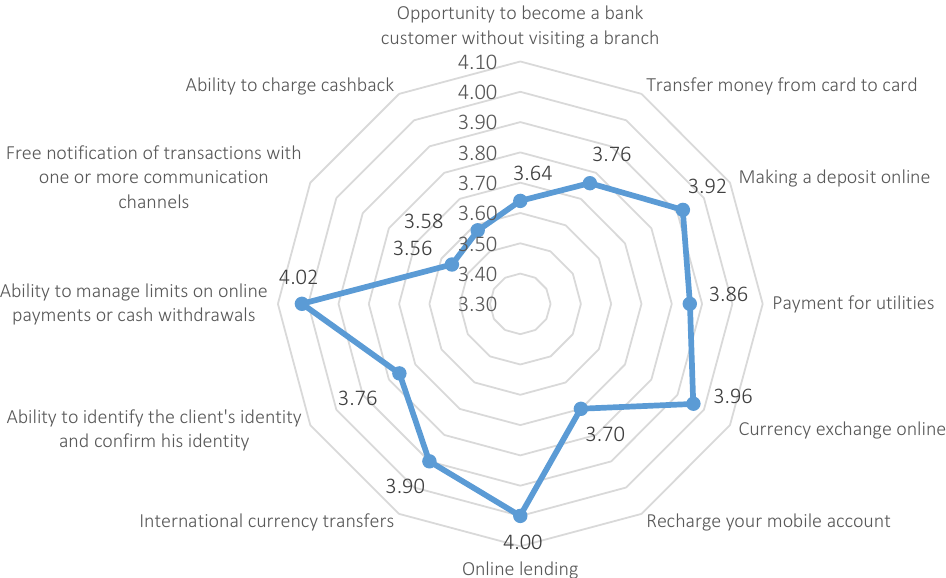
Figure 4. The impact of effective interaction between the bank and customers on specific areas of digital activity of Polish banks Table 3. The results of assessing the impact of effective interaction between the bank and customers on specific areas of digital activity of Polish banks Areas of digital activity of